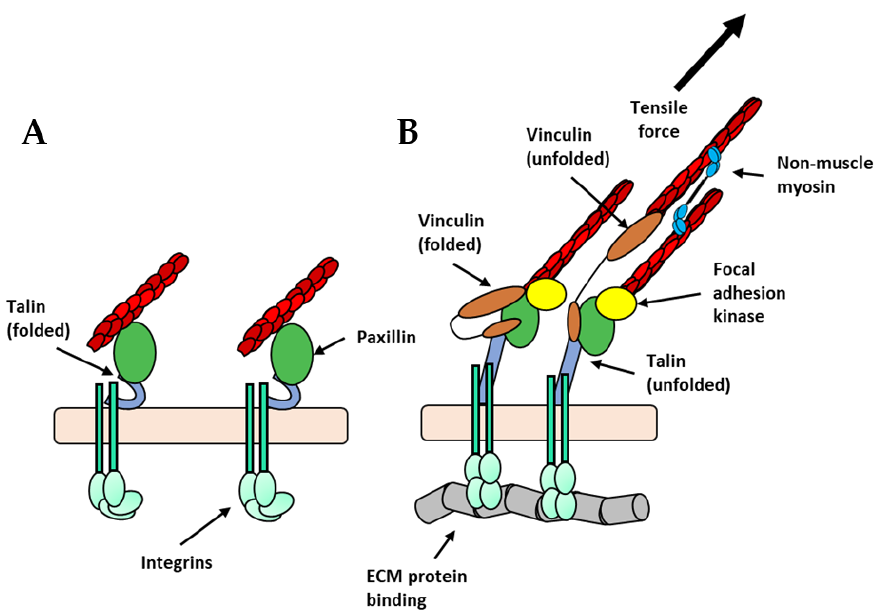
Figure 3. Hypothetical illustration of talin unfolding and growth of focal adhesions: ( A ) In the absence of ECM binding, integrins are in a bent, inactive state (light green), talin is in its folded conformation (grey-blue horseshoes), and paxillin (green ovals) is weakly associated with the actin filaments within the actin cytoskeleton. ( B ) When integrins engage with the ECM and when force is applied either intrinsically or extrinsically, talin is unfolded revealing cryptic vinculin-binding sites. Vinculin (brown ovals) is then recruited allowing for further engagement with actin filaments. Additionally, focal adhesion kinase (yellow circle) is recruited and activates downstream signals that culminate with increased non-muscle myosin contractility (light-blue ovals).